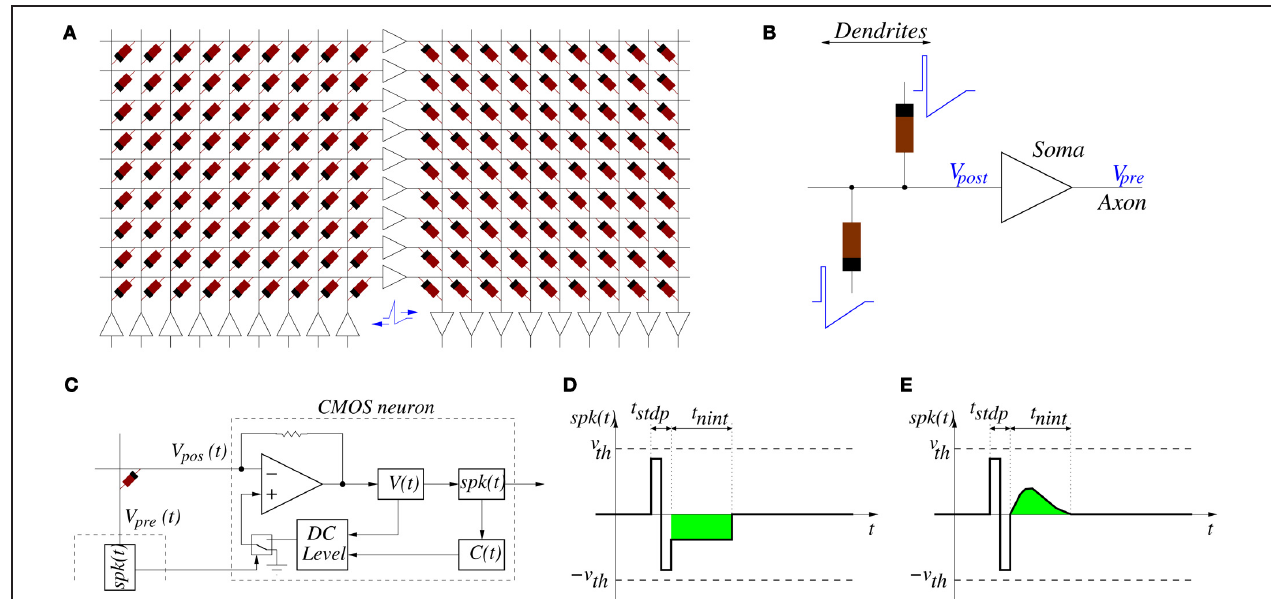
voltage spike at both nodes. (C) Implementation of single-spike STDP: block diagram of CMOS neuron together with single memristor synapse connected between pre- and post-synaptic neurons, (D) example spike waveform with negative square neural activation shape, and (E) example spike waveform with positive more biological neural activation